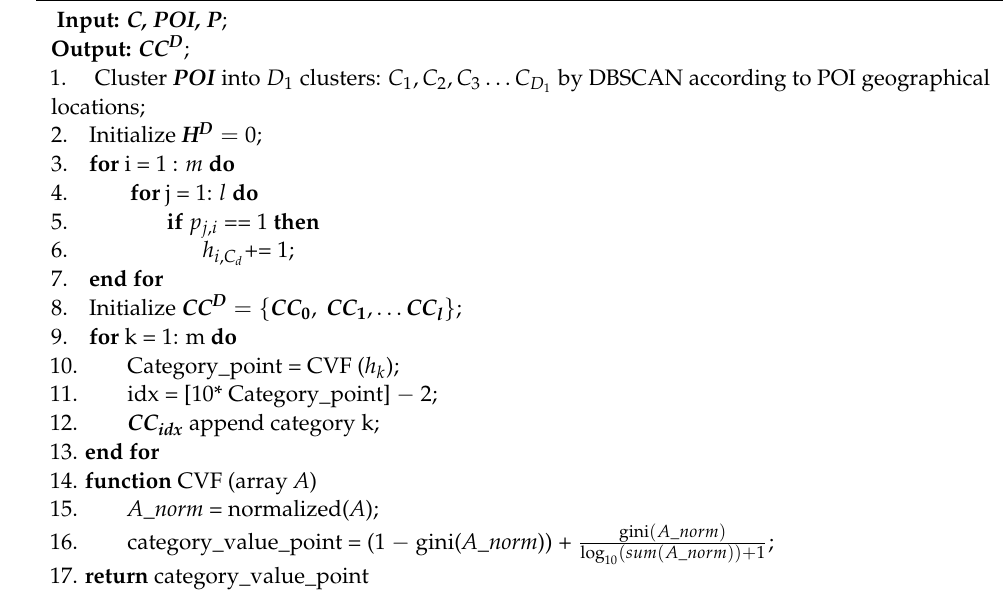
Algorithm 1 G-Clustering Algorithm